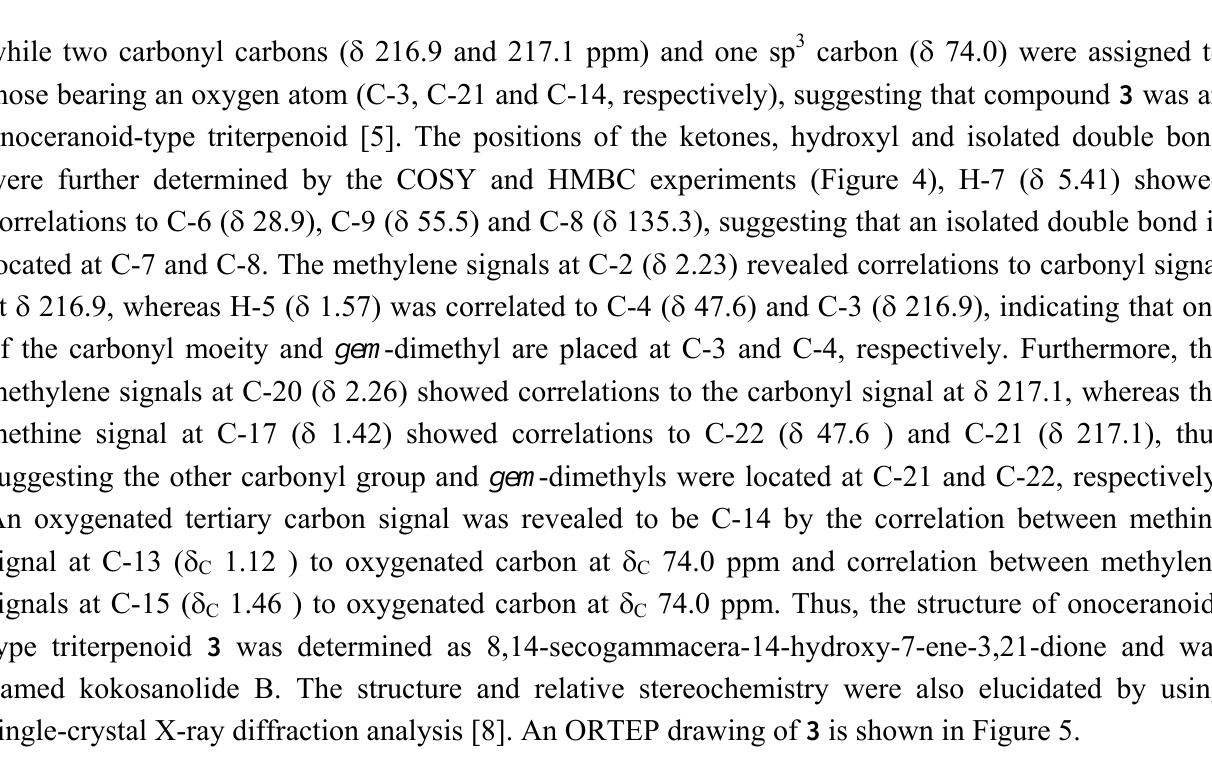
Figure 4. Selected HMBC (H → C) and COSY ( ) correlations for kokosanolide B.